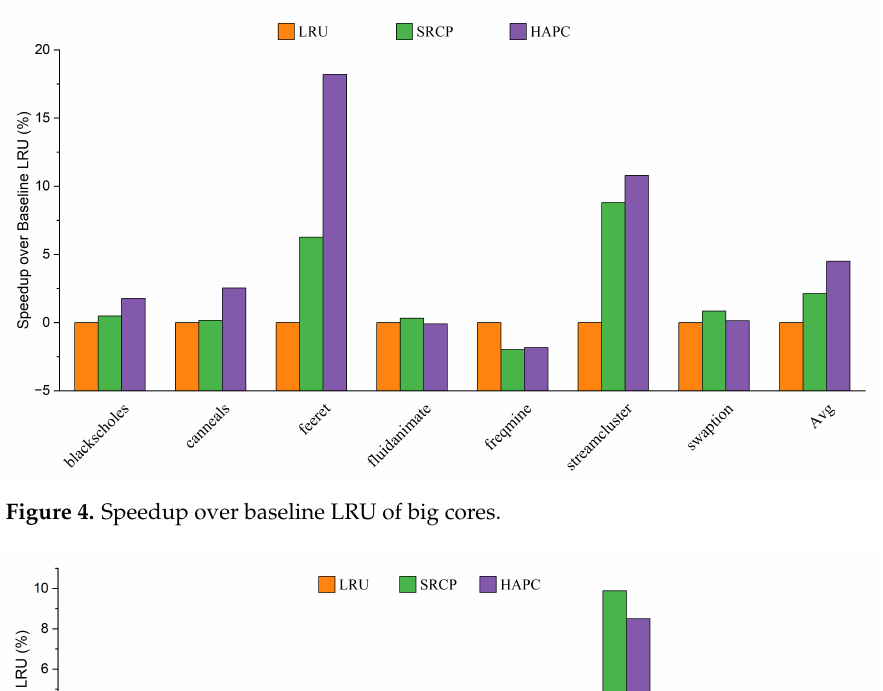
Figure 4. Speedup over baseline LRU of big cores.